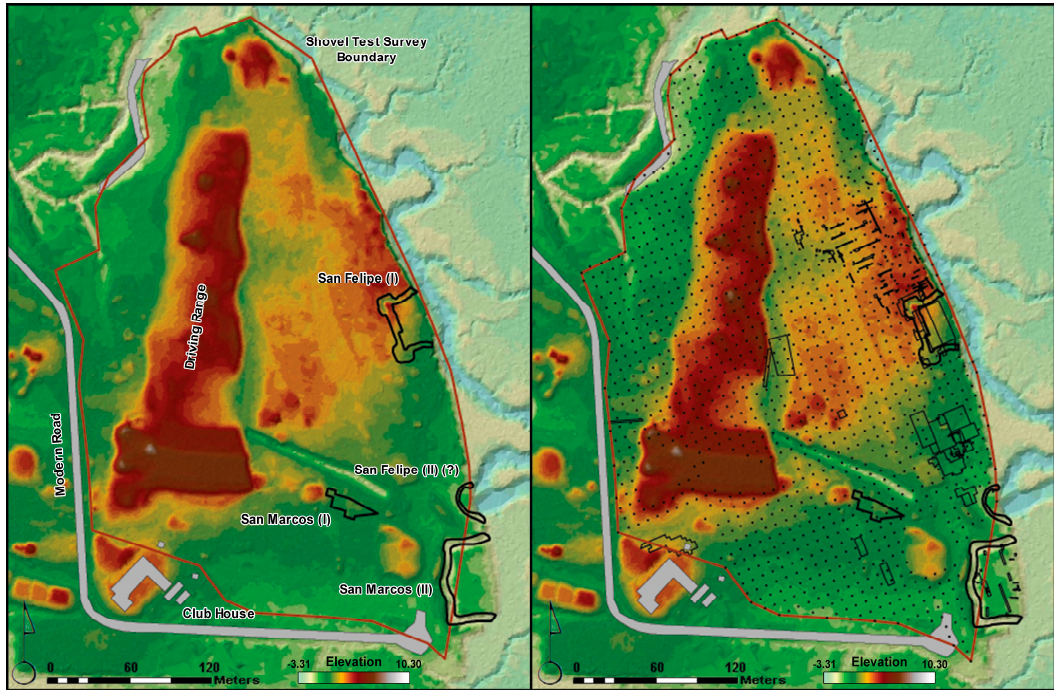
Figure 2. LiDAR map of the Santa Elena site with known Spanish forts and modern features labeled. The red outline indicates the extent of the shovel test survey. The map to the right includes the locations of each shovel test and the locations of previous block excavations at the site. Red indicates higher elevations. Green indicates lower elevations. LiDAR data were processed in ArcMap 10.2 with the LAS toolset using the NAD 1983 and NAV 1988 horizontal and vertical datum, respectively.